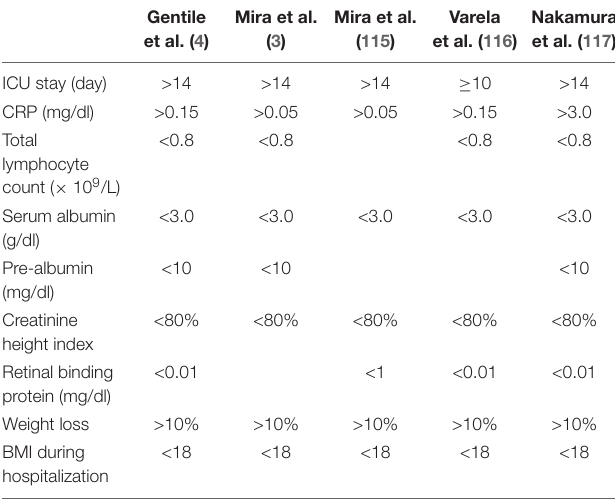
TABLE 1 | Diagnostic criteria for